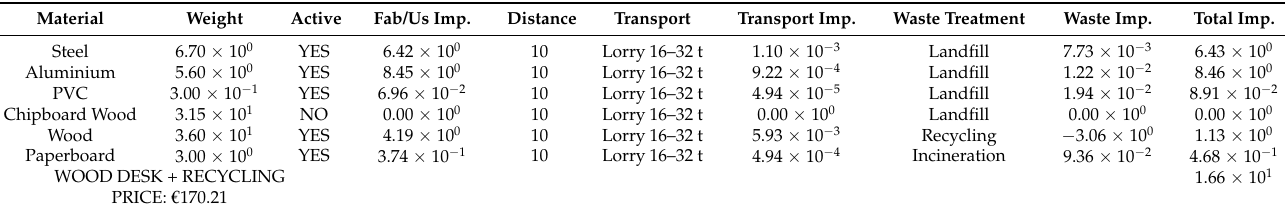
Figure 3. Environmental impact contribution for wood desk + recycling scenario.